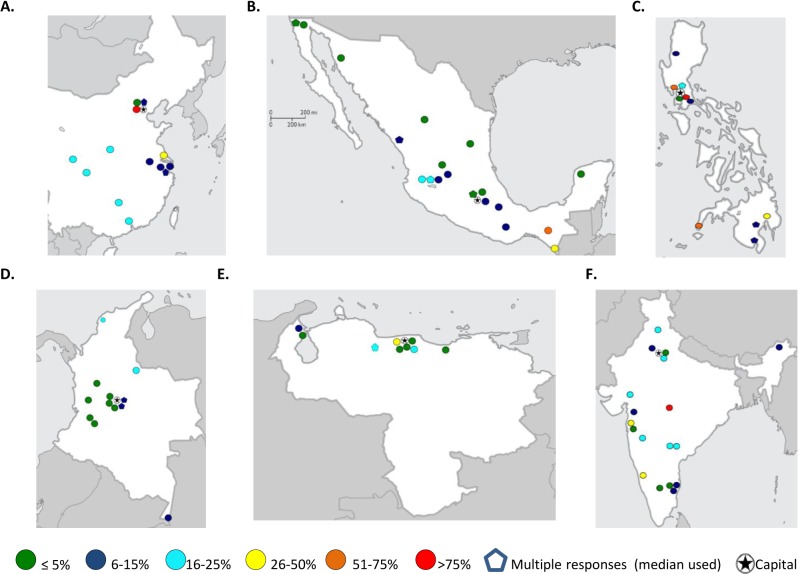
Geographical distribution of treatment abandonment (TxA) rates by city in countries with high in-country variability: China (A), Mexico (B), Philippines (C), Colombia (D), Venezuela (E), and India (F).